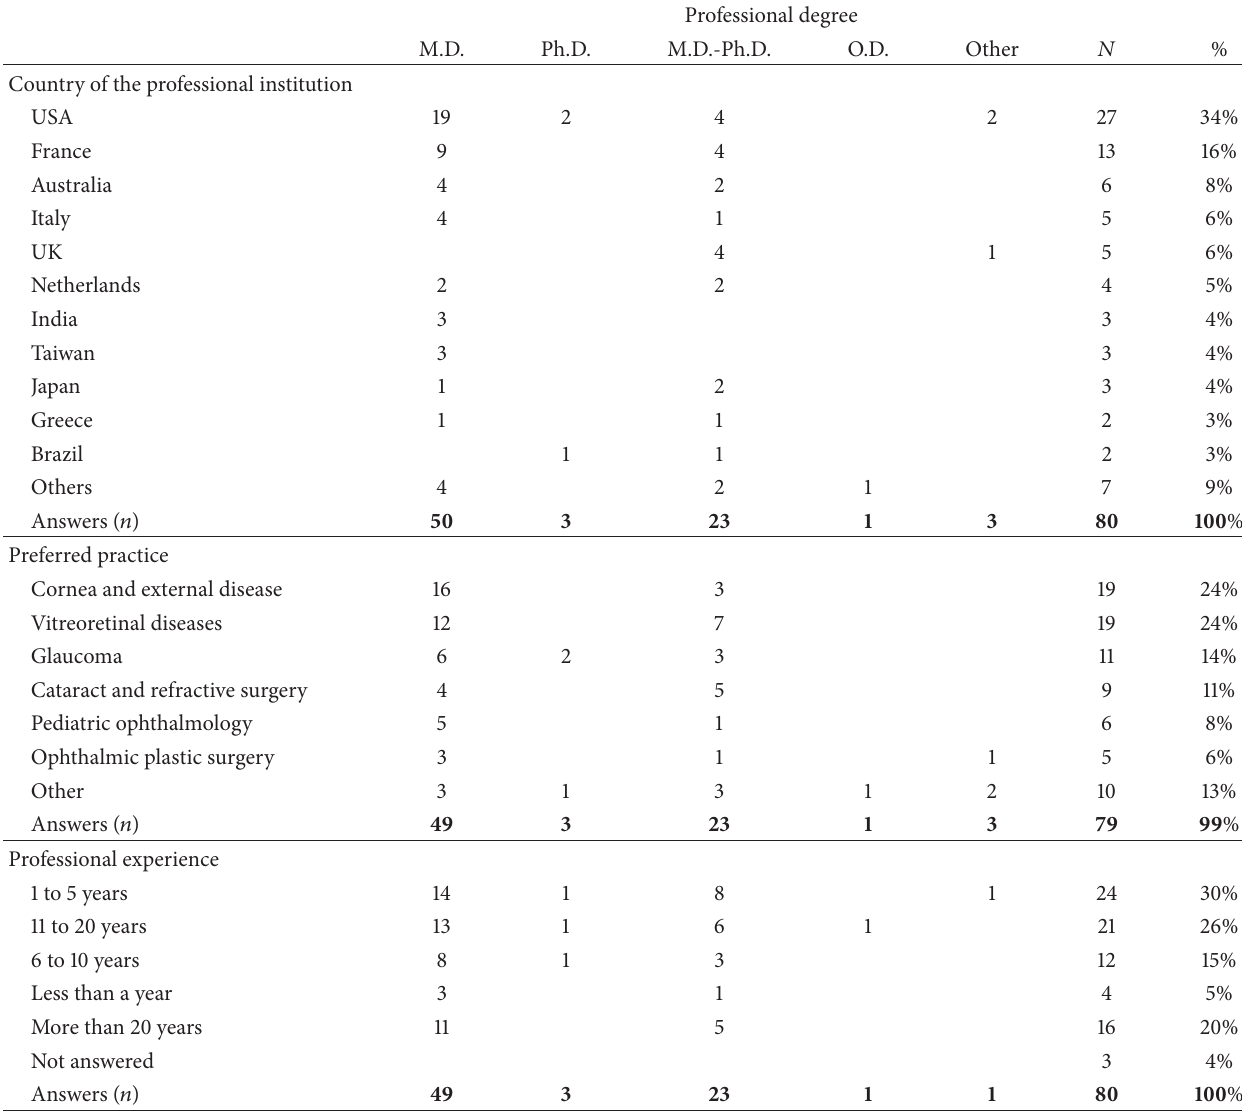
Table 1: Overview of preferred practices and experience claimed by participating